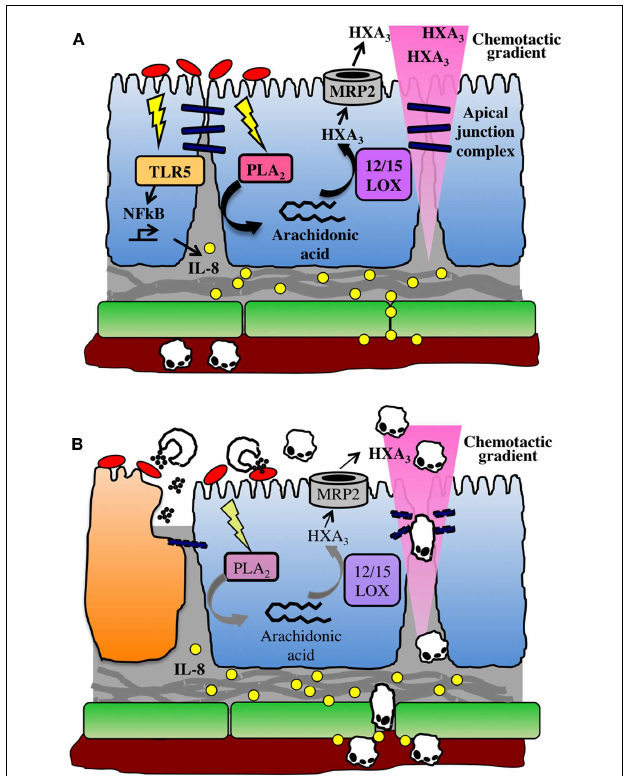
FIGURE 1 |The HXA 3 inflammatory pathway . (A) Infection of the epithelial cell (blue) surface by pathogenic bacteria (red) induces signaling through pattern recognition receptors, includingTLR5, and activation of NFkB, leading to pro-inflammatory responses including basolateral secretion of IL-8. An IL-8 gradient forms that is imprinted in the subepithelial extracellular matrix, and IL-8 binds to endothelial cell (green) surface in order to recruit neutrophils out of the vasculature. Meanwhile, bacterial infection activates phospholipase A2-mediated liberation of arachidonic acid from the plasma membrane. Arachidonic acid is converted to HXA 3 via the action of 12/15-lipoxygenase and secreted from the apical surface via the action of MRP2. HXA 3 released into the lumen diffuses across the paracellular junction between epithelial cells to create a concentration gradient that will recruit neutrophils across the epithelium. (B) Neutrophils extravasate through endothelial cells into lamina propria, where they sense the HXA 3 gradient, and migrate across the epithelial paracellular junction into the lumen.There, they encounter bacteria and release effectors including ROS and proteases, which can also lead to collateral damage to epithelial cells (dying cell shown in orange).